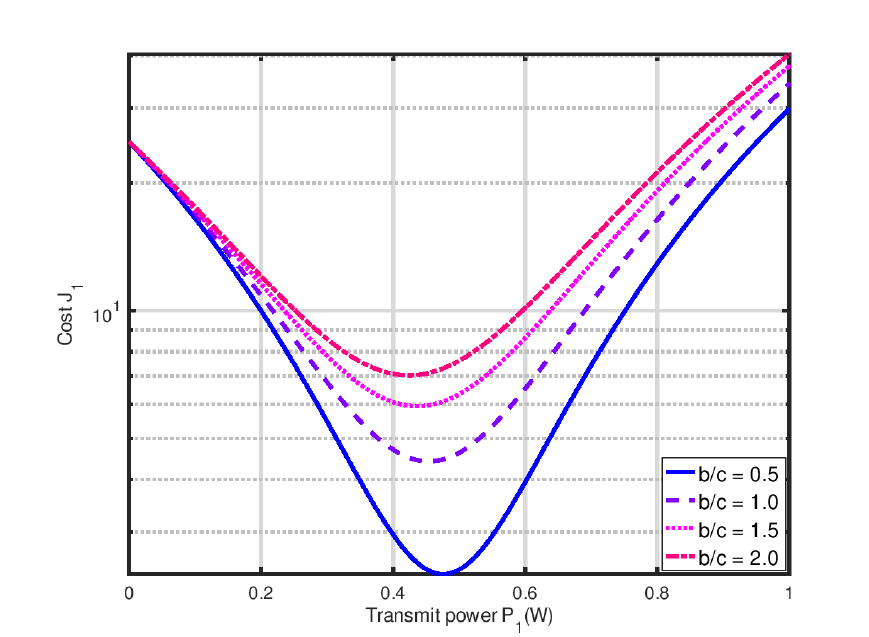
Figure 7. Nash equilibrium of D2D user depends on the pricing coefficients b i / c i